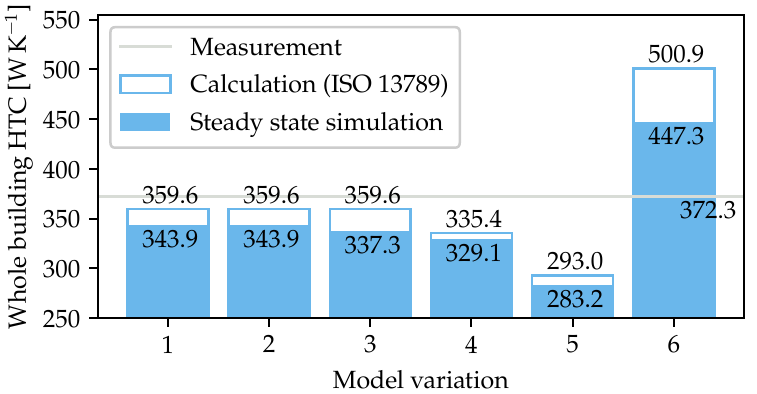
Figure 8. Comparison of HTC values from a steady state simulation and a calculation accord- ing to ISO 13789 for the model variations (see Section 2.4) with the measured value of the case study